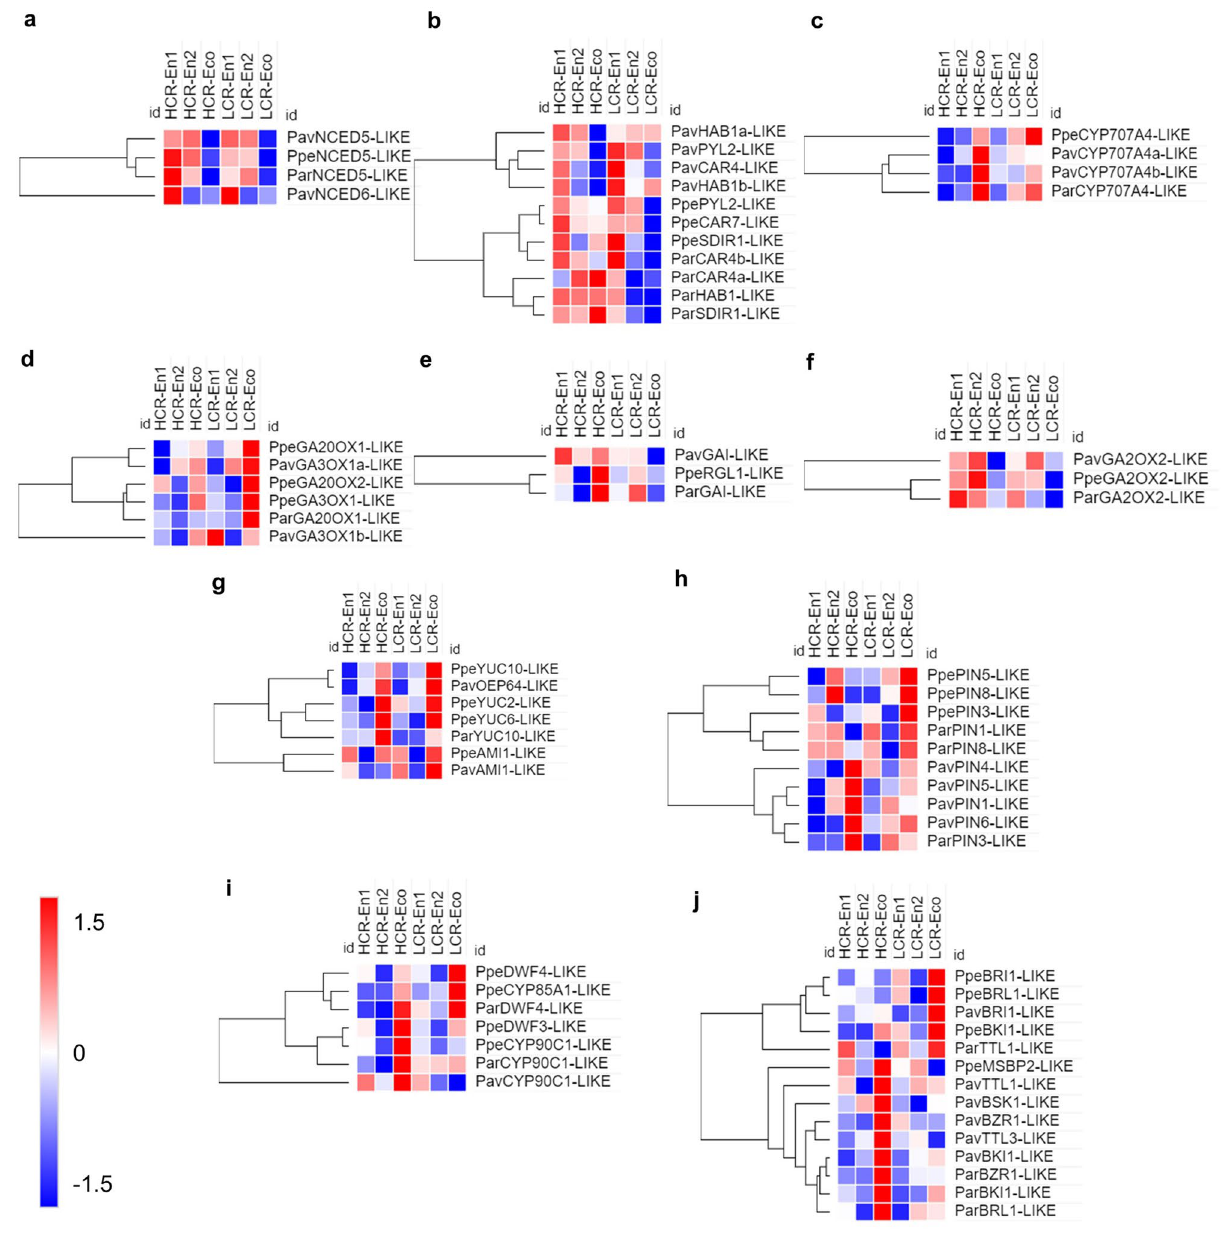
Figure 3. Independent heat maps were prepared for genes involved in ABA synthesis ( a ), signaling ( b ) and catabolism ( c ), GA synthesis ( d ) signaling ( e ) and catabolism ( f ) auxin synthesis ( g ) and transport ( h ), brassinosteroid synthesis ( i ) and signaling ( j ). Expression profiles of differentially expressed genes in endodormancy entrance (En1), endodormancy release (En2) and ecodormancy (Eco) in peach (Ppe), apricot (Par) or sweet cherry (Pav). For each species HCR and LCR genotypes are considered. z-score scaled DEGs expression levels are reported in red to blue color scale, corresponding to higher and lower expression,